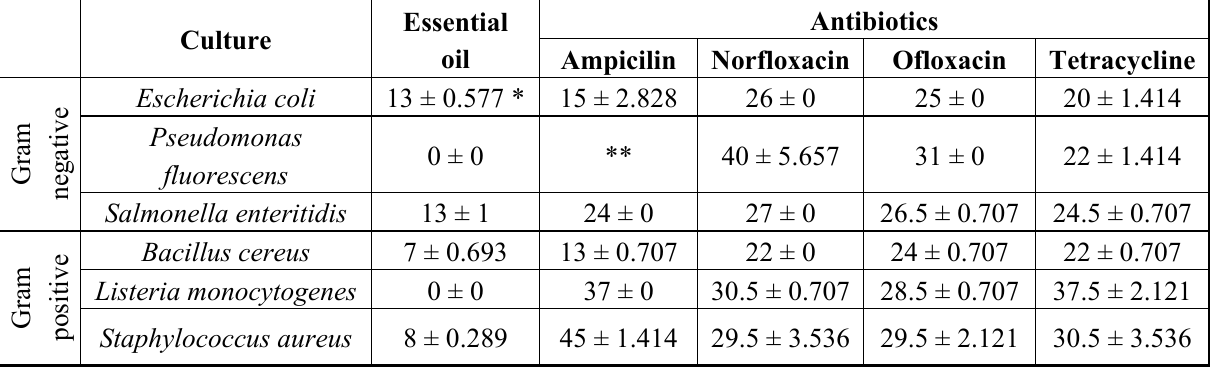
Table 3. Inhibition zones of C. erythraea essential oil to tested bacterial species (in